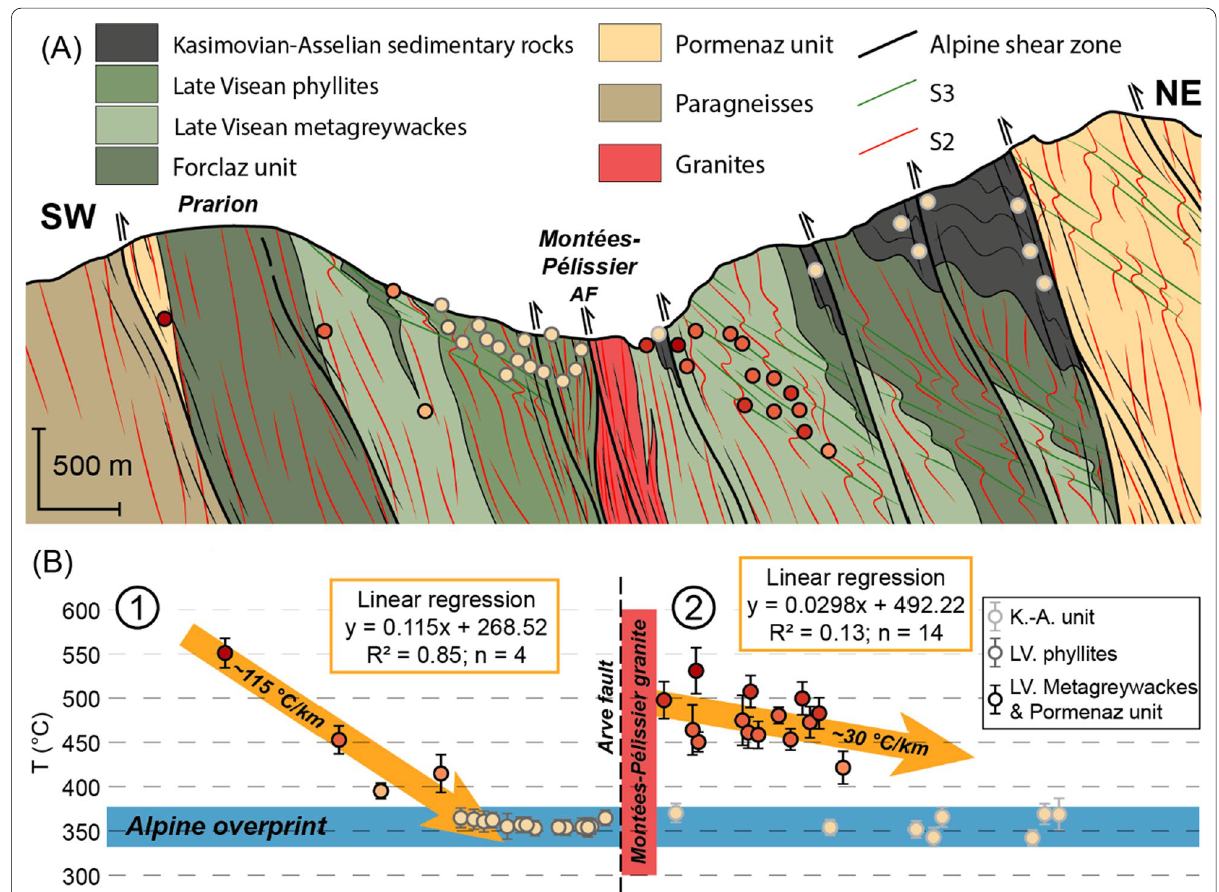
Fig. 7 A Cross‑section in through the Servoz syncline with projected RSCM temperatures. AF: Arve Fault. B Apparent gradients from (1) western and (2) eastern side of the Servoz syncline calculated on Famennian – Early‑Visean samples. Colour of each sample is related to its T RSCM